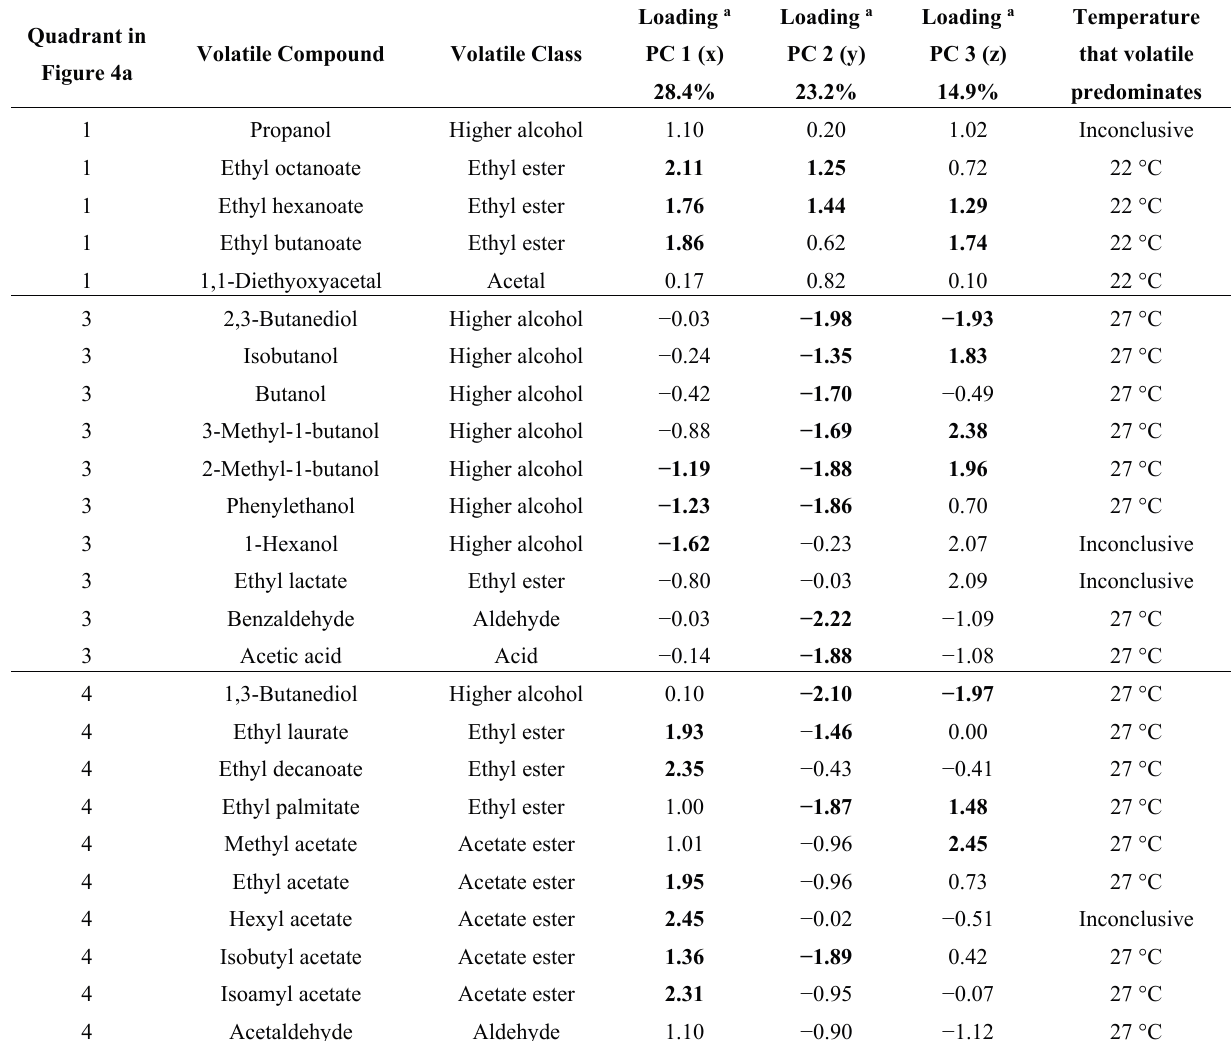
Table 5. Identification and principal component analysis factor loadings (PC 1, PC 2, PC 3) for 25 volatile compounds in the headspace of Pinot noir, fermented with industrial strains and individual- and mixed-Burgundian